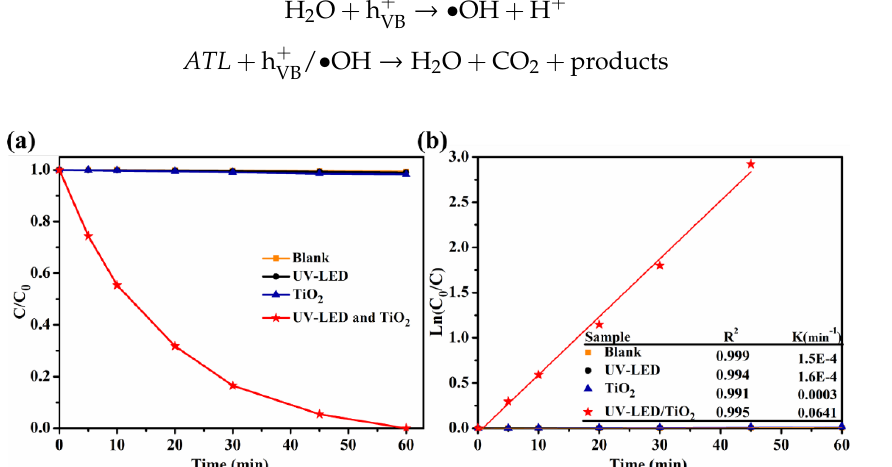
Figure 3. ( a )ATL degradation efficiency under different conditions, ( b ) Pseudo- first-order model of ATL degradation. the initial ATL concentration of 18.77 µM and mixed phase concentration of 2.0 g/L; UV-LED wavelength: 365 nm; I 0 = 774 µW/cm 2 ; pH: 7.6; temperature: 20 °C. UV-LED wavelength: 365 nm; I 0 = 774 µ W / cm 2 ; pH: 7.6; temperature: 20 ◦